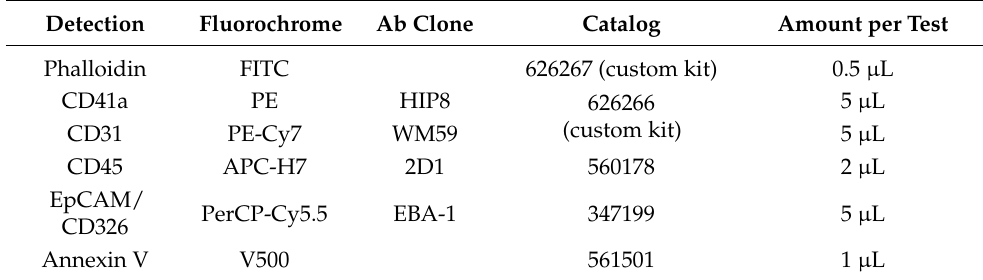
Table 1. List of flow cytometry specificities and reagents 1